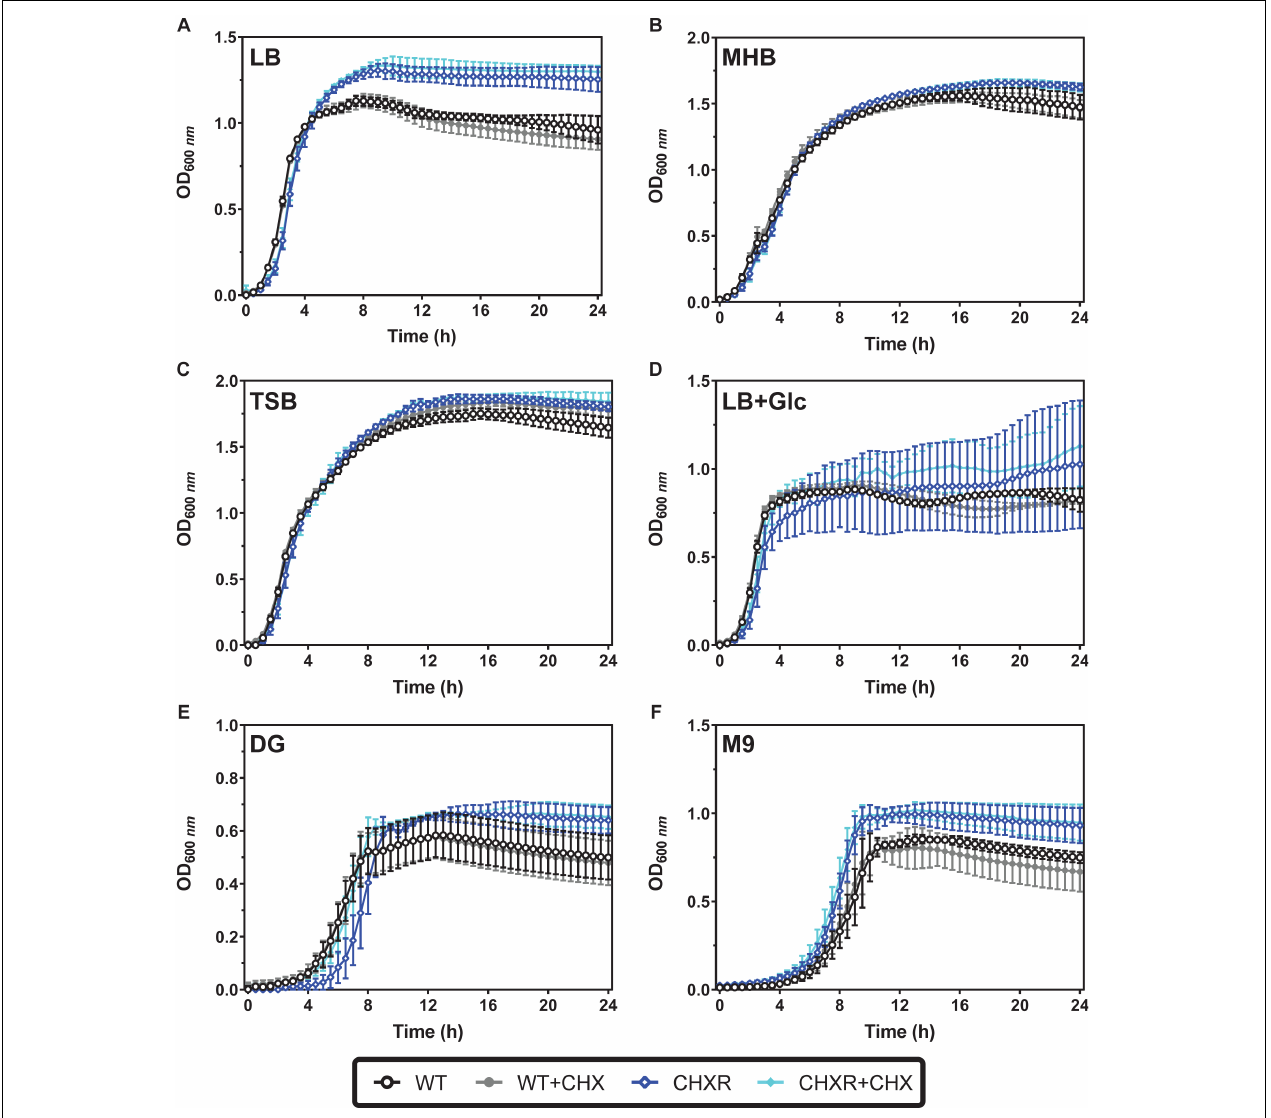
FIGURE 1 | Growth curves of WT and CHXR isolates in rich and minimal media with and without CHX selection. In all panels, growth curves were measured from optical density values at 600 nm (OD 600 nm ) in 96-well microtiter plates incubated at 37 ◦ C with shaking over 24 h. Averaged values from CHXR1-3 isolates and WT measured in biological triplicate are plotted in each panel, and error bars highlight standard deviation of OD 600 nm values at each timepoint. In all panels, CHXR isolates are plotted as blue shaded diamonds and WT as circles, where solid filled symbols indicate samples grown in the presence of 0.4 µ m/mL CHX final concentration and unfilled symbols indicate media growth without CHX selection. Media with and without CHX addition used to measure the growth of each isolate/strain is shown in each panel: (A) LB, (B) MHB, (C) TSB, (D) LB + 0.4% w/v glucose (LB + Glc), (E) DG, and (F)